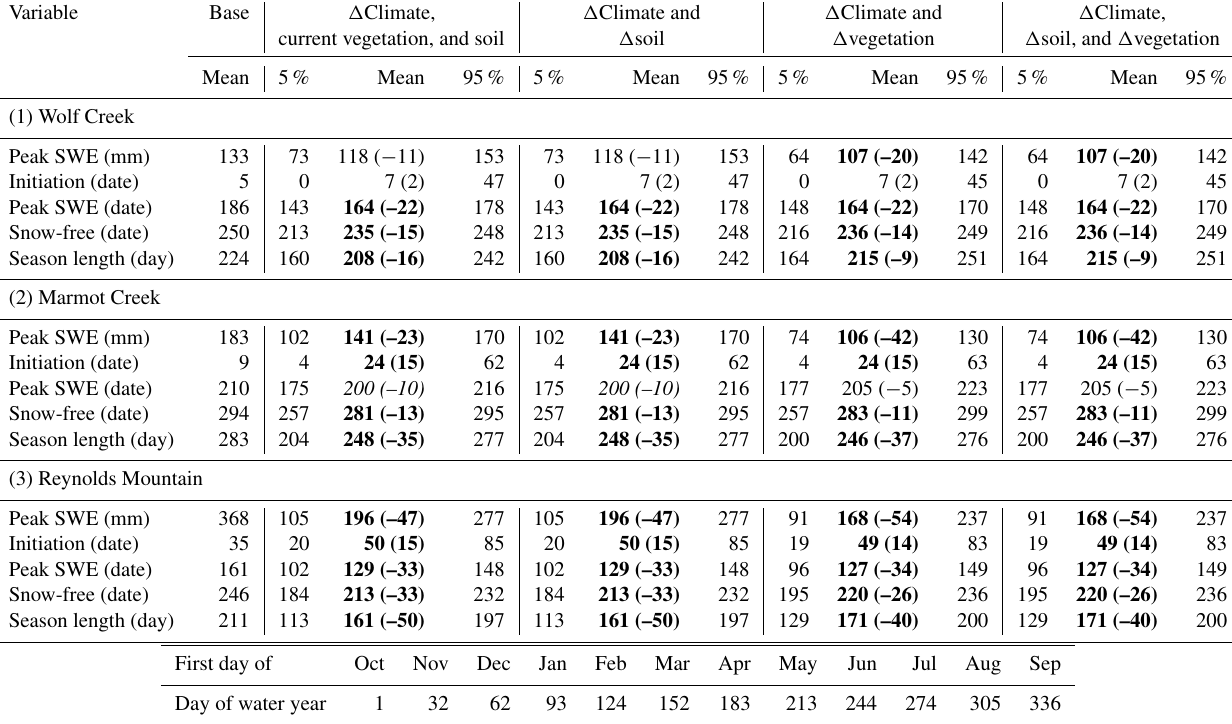
Table 4. Simulated snow characteristics under current and monthly perturbed climate and future vegetation and soil in the three basins. Bold and italic values denote significant changes with p values of less than 0.05 and 0.1, respectively. Changes, relative to current cli- mate/vegetation/soil, are given in parentheses. Dates are given in water year